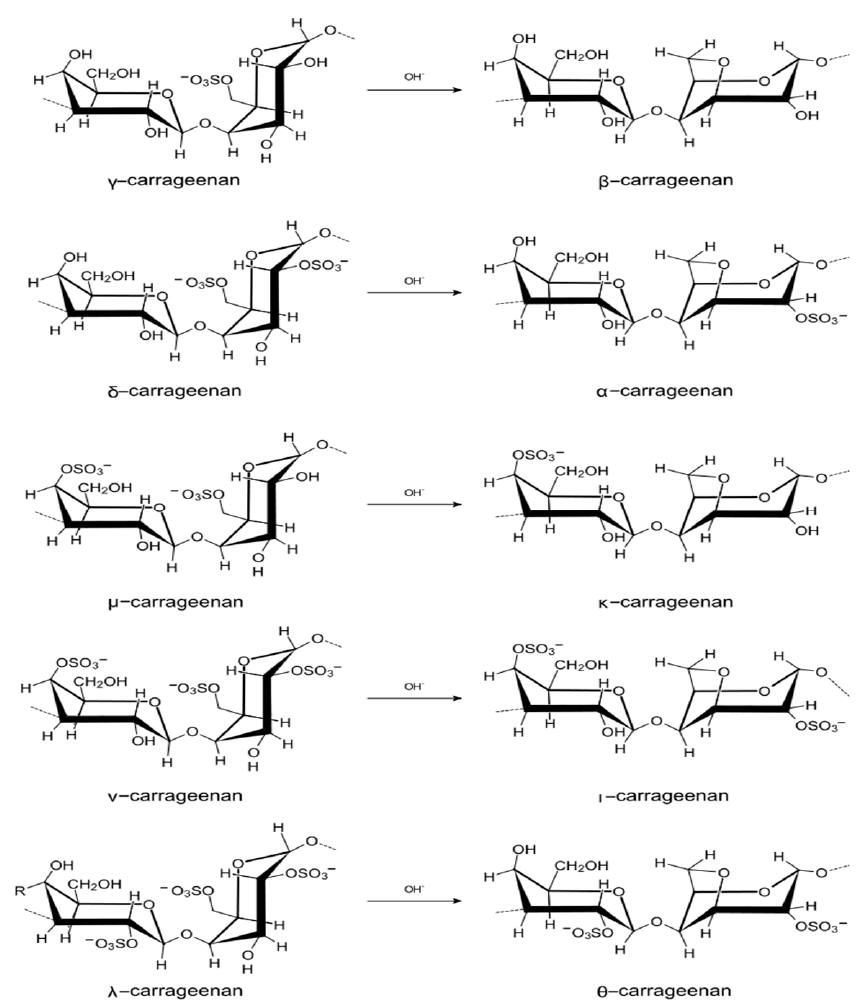
Figure 1. Structural fragments of carrageenans.